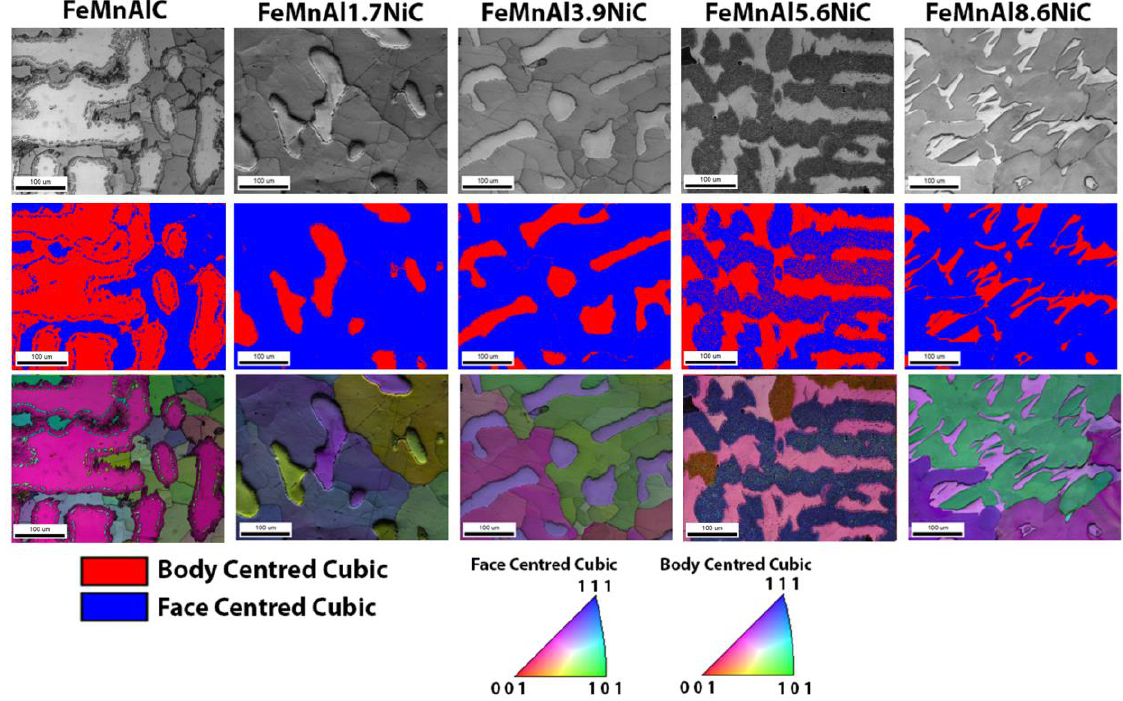
Figure 3. Electron backscattered diffraction analysis of as-cast FeMnAlC samples with different Ni contents.